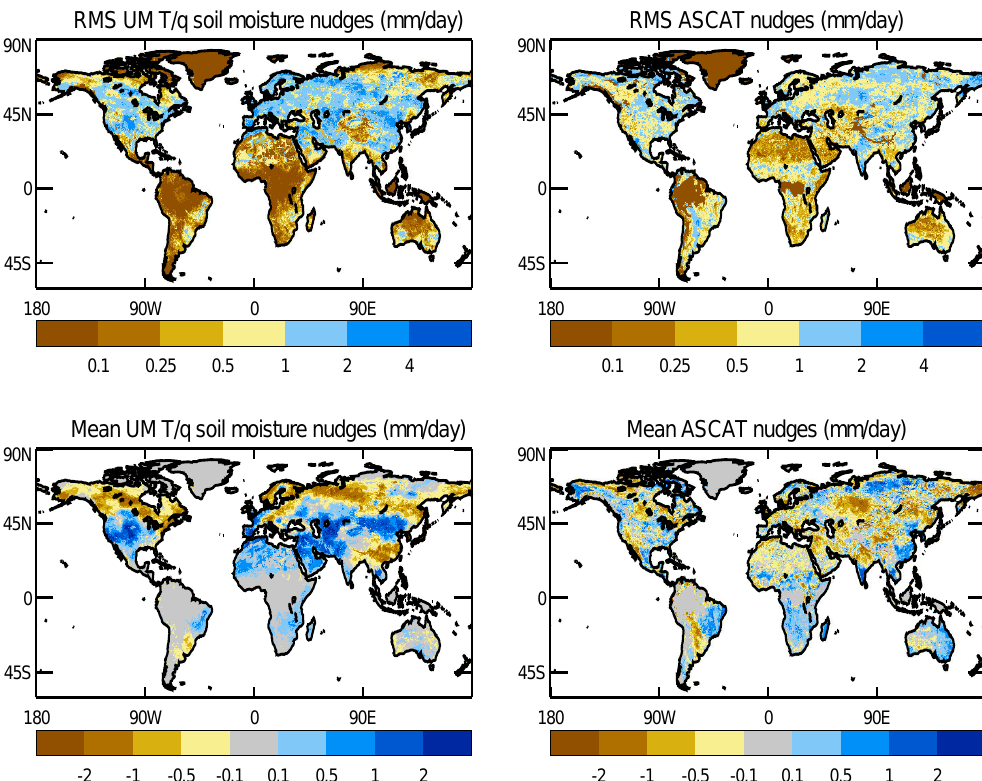
Fig. 6. RMS (top panels) and mean (lower panels) size of soil moisture nudges (mm day − 1 ) from trial 1 for the July 2009 period. The left panels shows nudges in the top 1 m of soil by the UM T/q soil moisture nudging scheme in the Control experiment. The right panels shows nudges in the topmost UM soil level by the ASCAT nudging in the Test experiment.